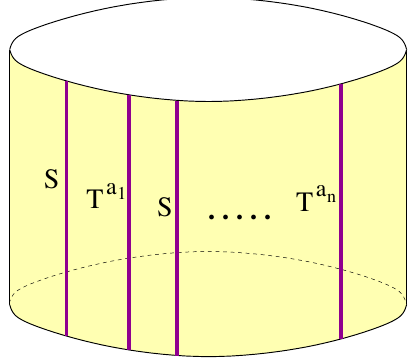
Figure 4 . Reducing T [(cid:6) (cid:2) S 1 ] on a circle, with S and T duality walls inserted at points on a circle. imposes a